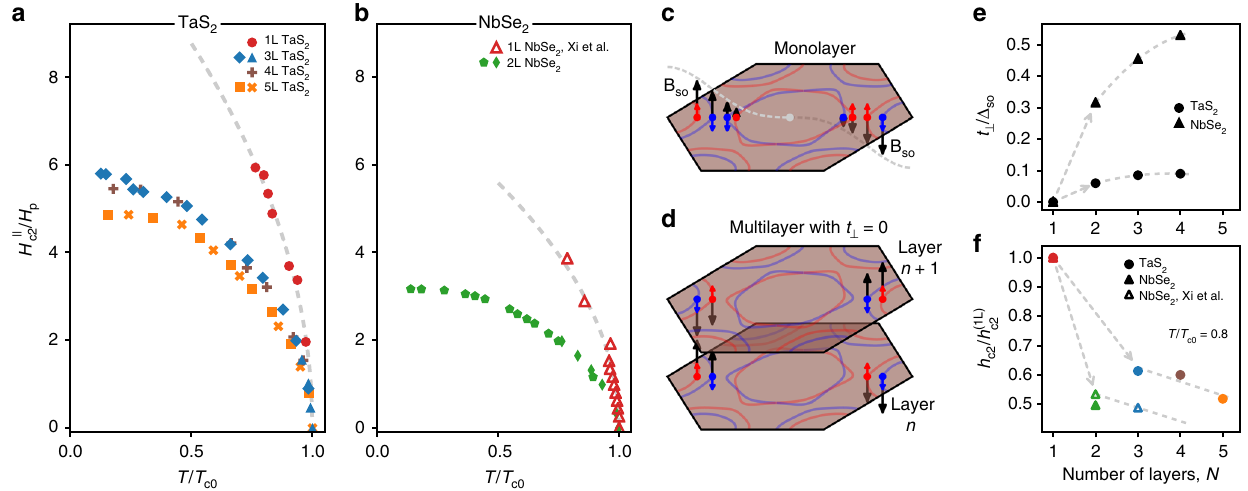
= H p , as c2 ¼ 122meV and Δ NbSe 2 ¼ 49 : 8 meV . Dashed lines are provided as so so = H T / T = 0.8 on the number of TaS c0 2 or NbSe 2 layers, including p evaluated at c2 to enable direct comparison c2 the spin susceptibility in the superconducting state χ s goes to zero as T → 0, whereas in the normal state the susceptibility is given by ¼ χ (cid:3) 2 μ 2 N E F ð Þ . the Pauli paramagnetic susceptibility χ B n p Together, the difference in susceptibilities yields the Pauli limiting ffiffiffi p fi eld, H ¼ Δ = μ 2 . For weak-coupling p 0 B As shown in Fig. 4a, b for in-plane fi elds, the trend toward jj ð 0 Þ is many times larger than the Pauli limit H H p for all c2